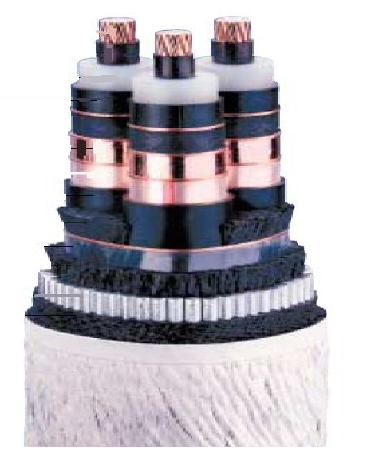
Figure 3. Diagram of the cable [1]. Table 1. Material table assigned to single-phase cable